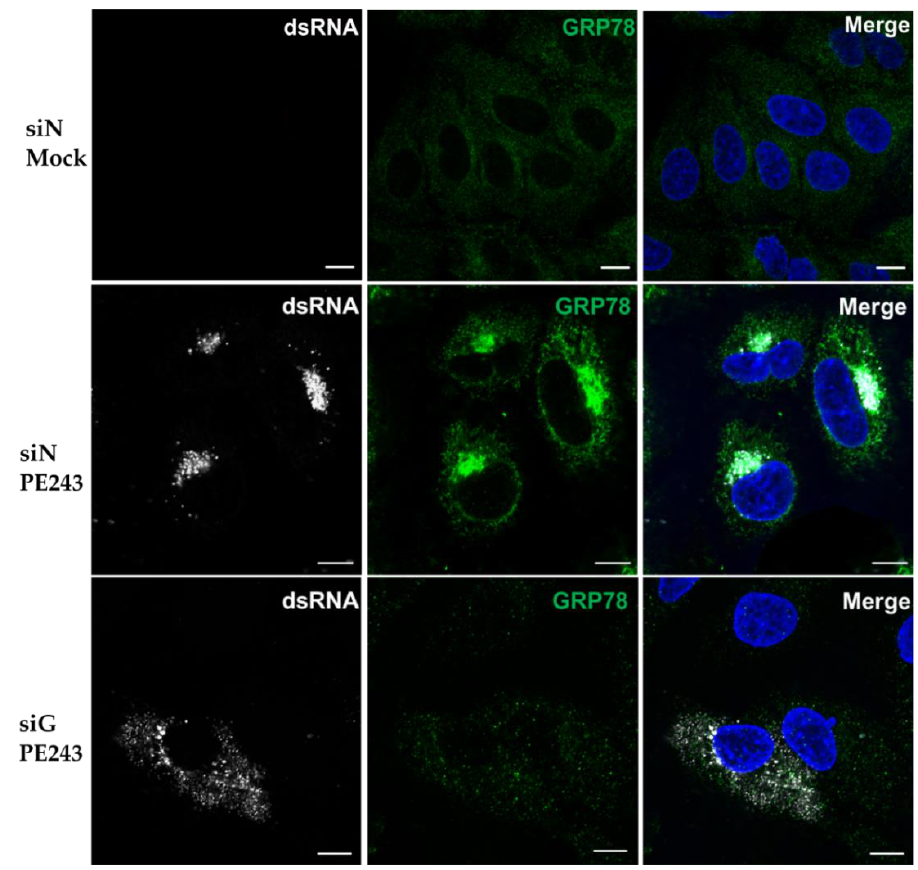
Figure 5. Viral dsRNA localisation is altered following GRP78 depletion. A549 cells were treated with siN or siG and mock infected or infected with ZIKV PE243 at MOI 0.1 for 24 h. Cells were stained with an anti-dsRNA antibody (white) and an anti-GRP78 antibody (green), and the nuclei were stained with DAPI (blue). Images were taken on an LSM 710 confocal microscope. Scale bars represent 10 µm, and images are representative of triplicate experiments.